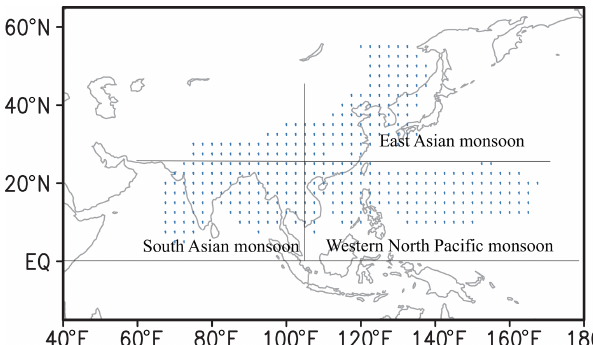
Figure 1. Spatial distribution of the Asian monsoon region (stip- pled, blue) including East Asian, South Asian and western North Pacific monsoon regions based on the CMAP data from 1979 to